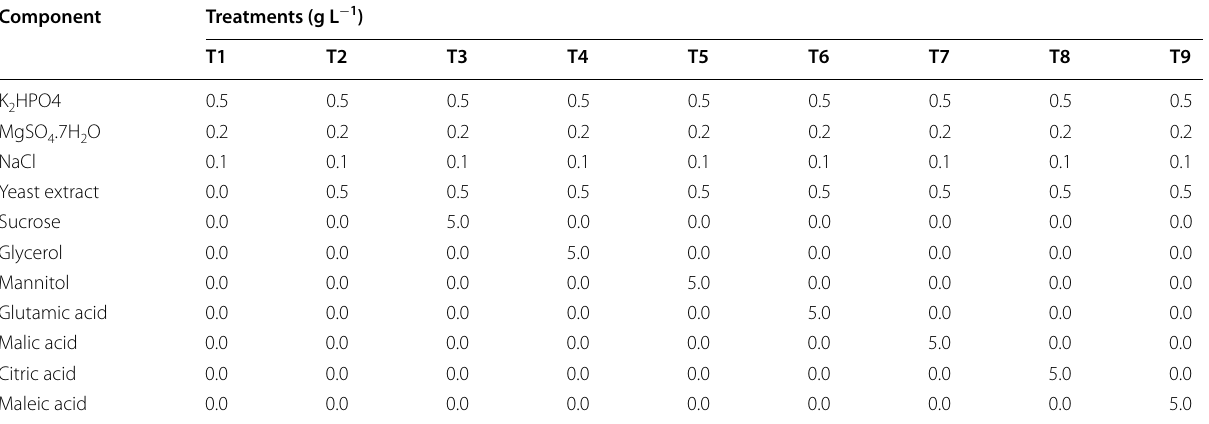
Table 1 Composition of the culture media to verify the use of different sources of carbon by Bradyrhizobium japonicum , Bradyrhizobium diazoefficiens and Azospirillum brasilense